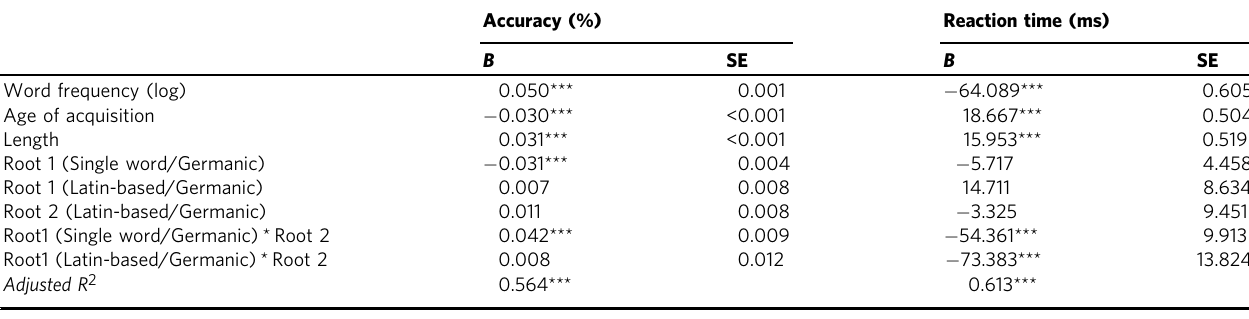
Table 6 English Crowdsourcing Project L2: regression model results for lexical decision task (accuracy and reaction